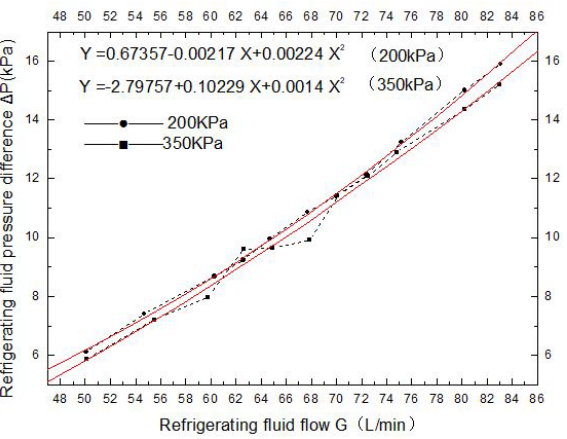
Figure 7. Variation of pressure drop with flow rate (temperature 40 C ° ).